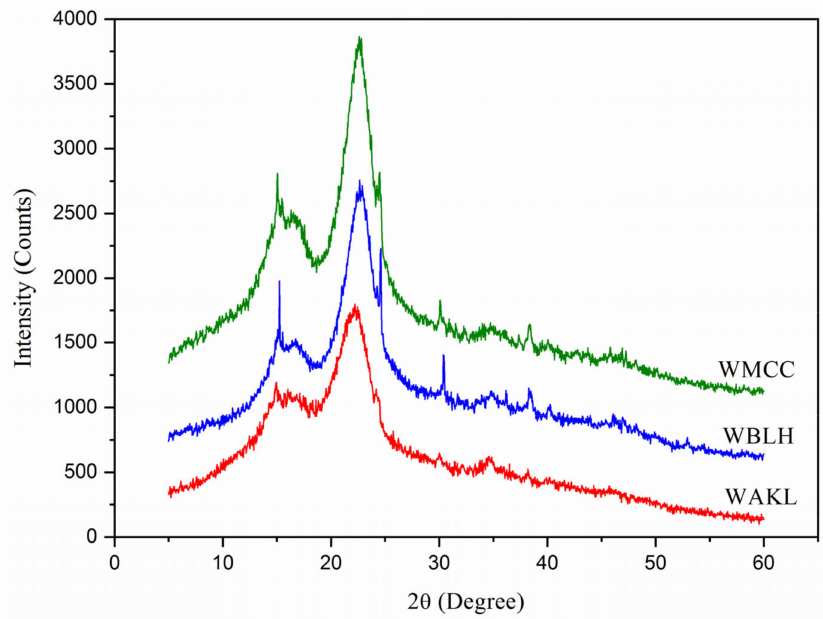
Figure 4. XRD patterns of WAKL, WBLH, and WMCC